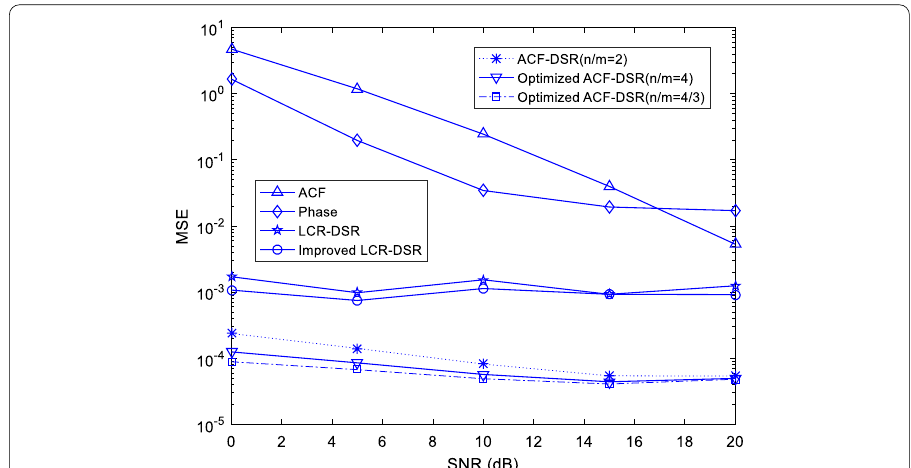
Fig. 8 The MSE comparison of the optimized ACF-DSR method and previous methods